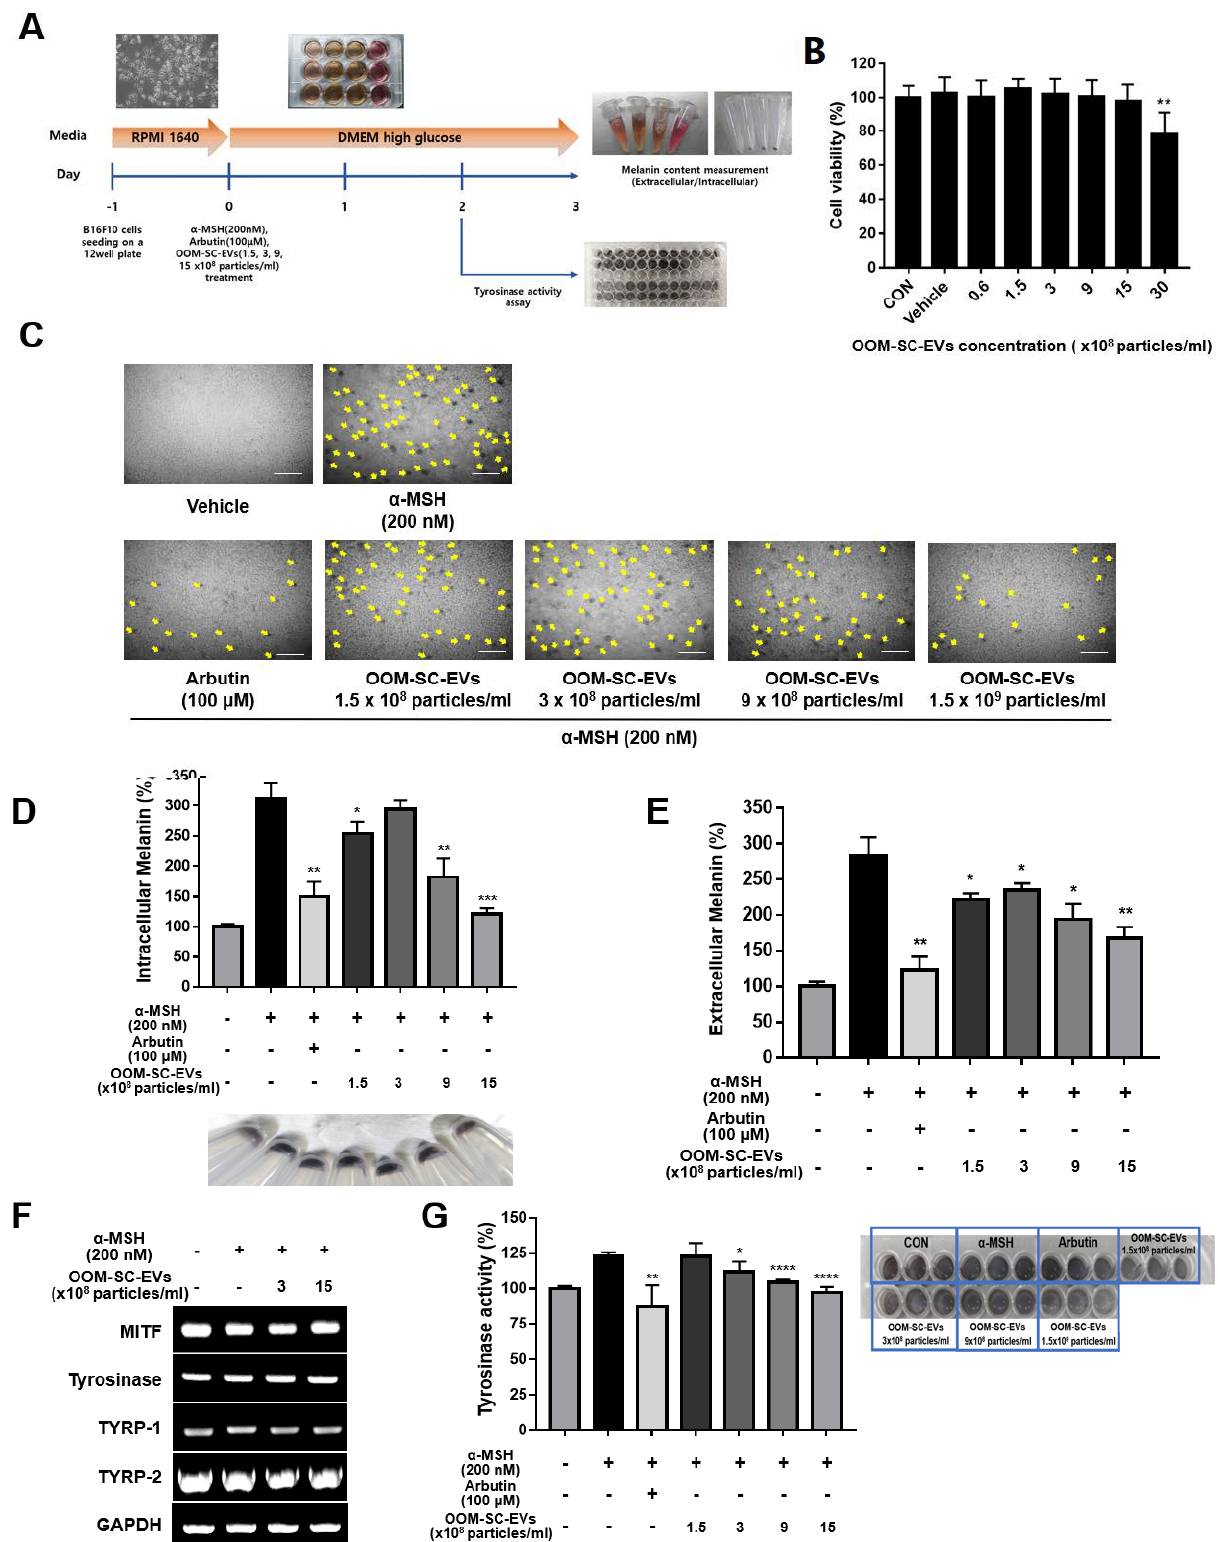
Figure 5. Modulatory effects of OOM-SC-EVs on melanin synthesis and tyrosinase activity. ( A ) A representative scheme elucidates the experimental schedule for evaluating the effects of OOM-SC-EVs on melanin synthesis and tyrosinase activity. In this experiment, we cultured B16F10 melanoma cells using a growth medium (RPMI 1640). The cells were then